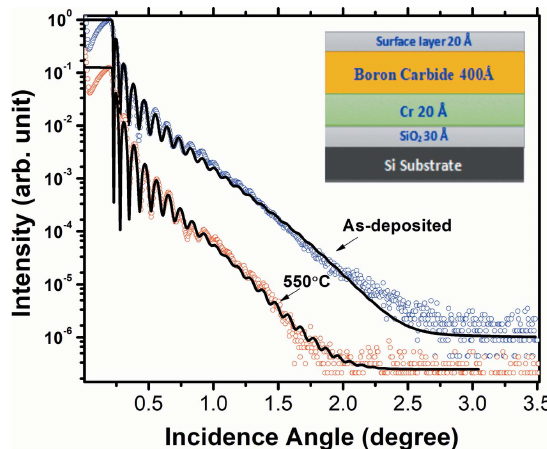
Figure 1 Measured (open circles) and fitted (continuous line) GIXRR curves of as- deposited and 550 (cid:2) C annealed boron carbide/Cr bilayer samples. The layer model used to obtain the best fit is also shown. For the sake of clarity, the curves are vertically shifted.